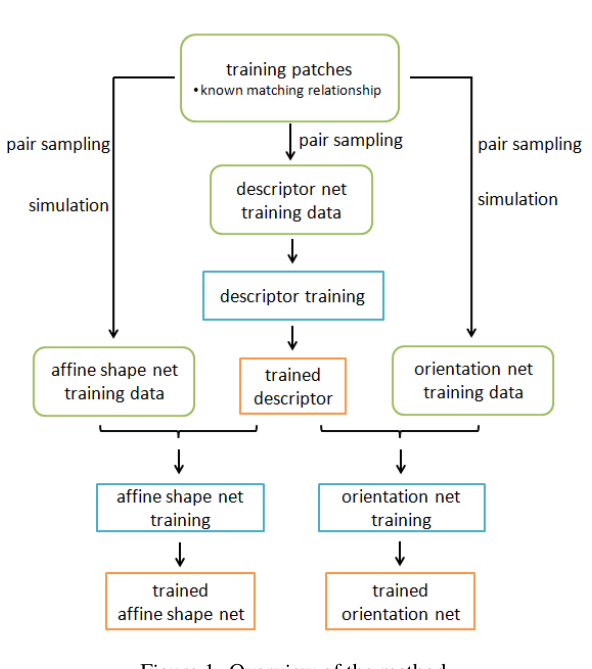
Figure 1. Overview of the method.